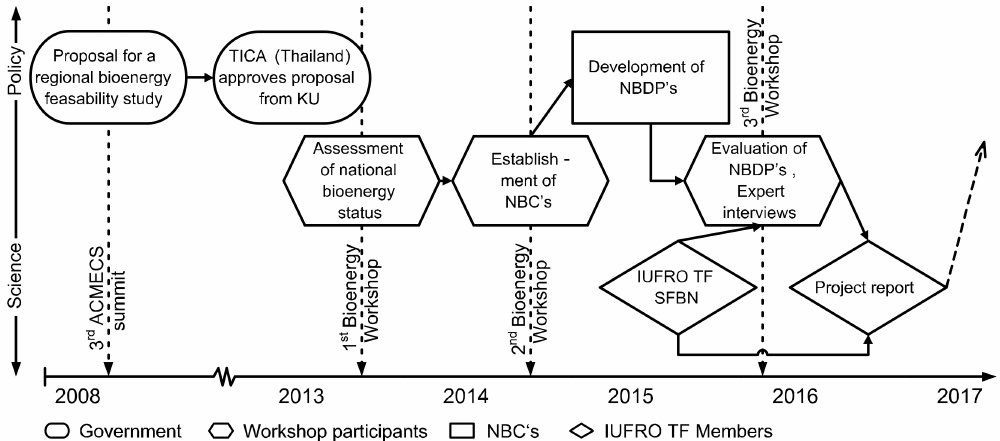
Figure 1. Schematic diagram of the key milestones of the regional bioenergy network development in the ACMECS countries. ACMECS = Ayeyawady-Chao Phraya-Mekong Economic Cooperation Strategy; TICA = Thailand International Cooperation Agency; KU = Kasetsart University, Bangkok, Thailand; NBC = National Bioenergy Committee; NBDP = National Bioenergy Development Plan; IUFRO TF SFBN = Sustainable Forest Biomass Network Task Force of the International Union of Forest Research